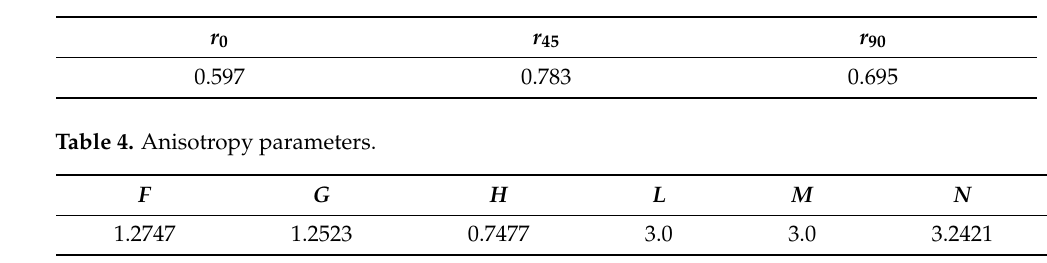
Table 3. Lankford coefficients.